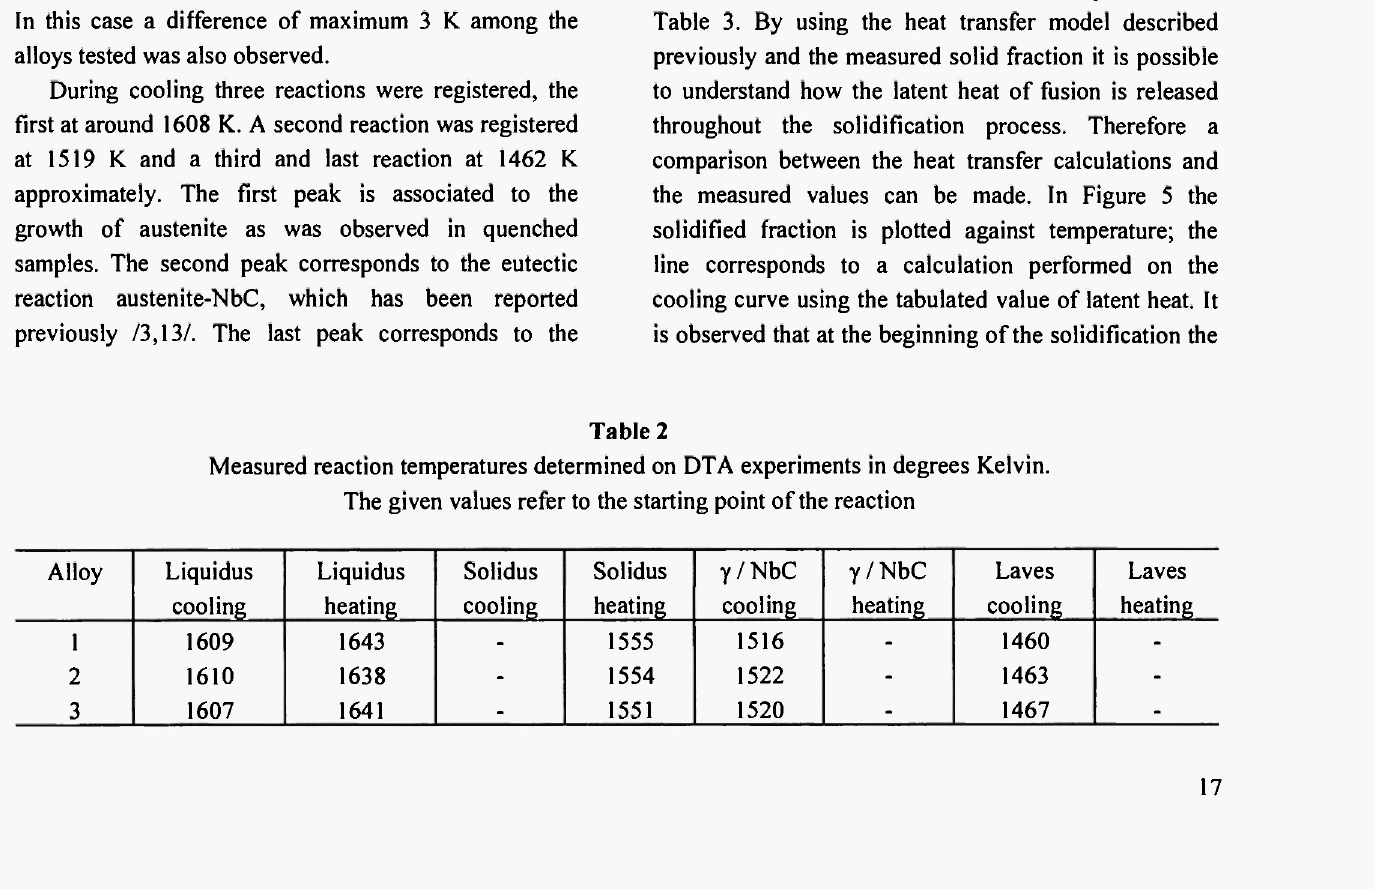
precipitation of the ternary eutectic or Laves phase, which represents the end of the solidification process. The fact that the last two peaks are relatively small compared to the first peak indicates that the fraction precipitated during these reactions is rather small compared to the primary